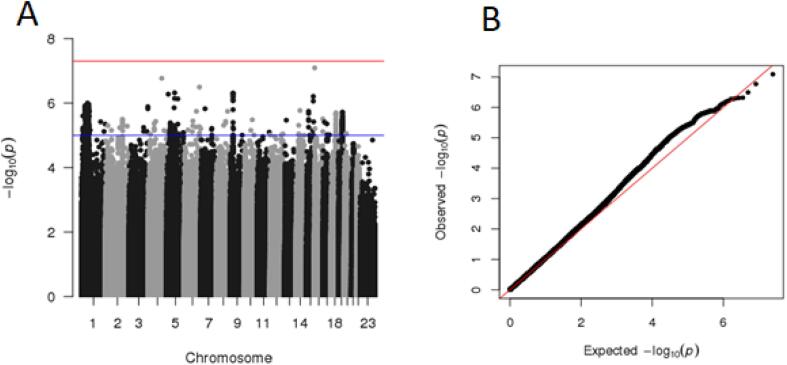
A) Manhattan plot and B) quantile–quantile plot of self-harm genome wide association study results in UK Biobank.